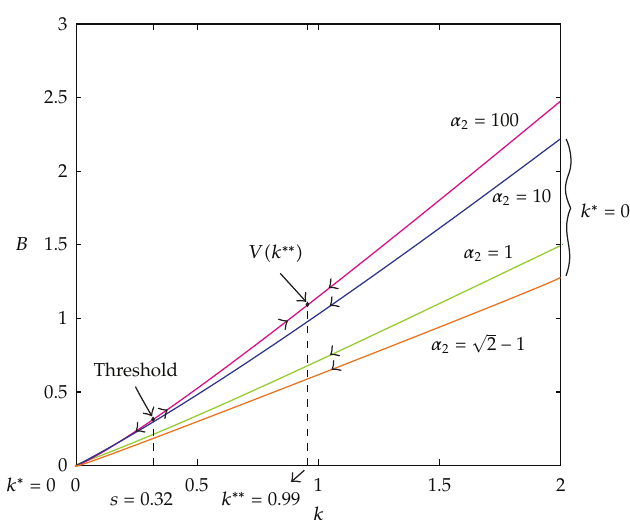
Figure 3: Present value curve V (cid:3) k (cid:6) for di ff erent α 2